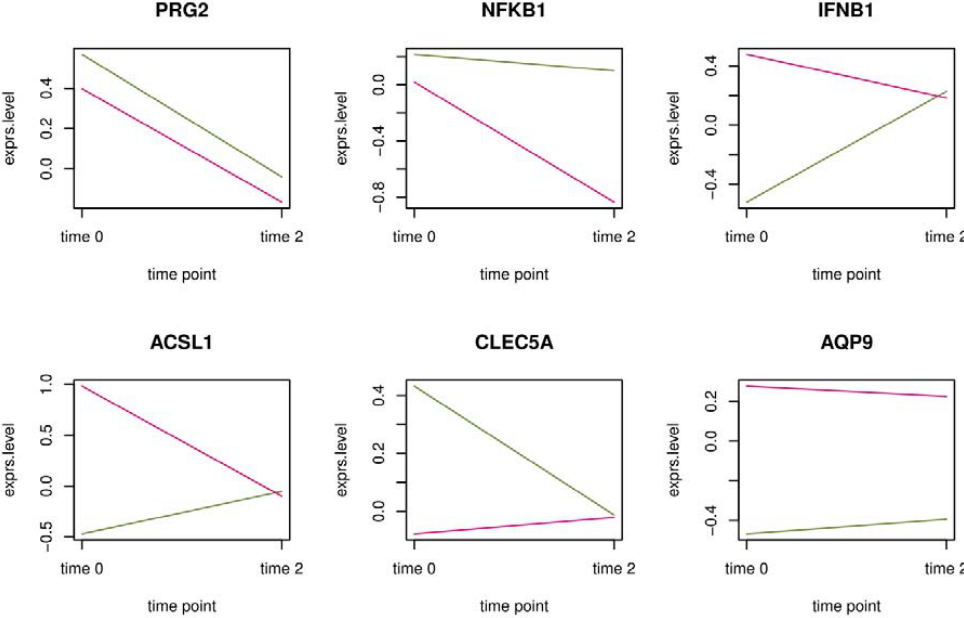
Figure 6. Time series plots of gene expression without fold change for the six marker genes proposed by the China benzene exposure study. Pink: Average gene expression in referents. Green: Average gene expression in exposed workers.